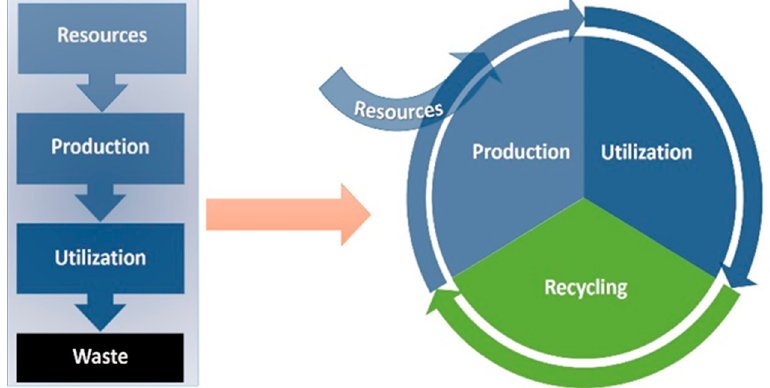
Figure 1. From a linear to a circular agro-food system (Source [1]).